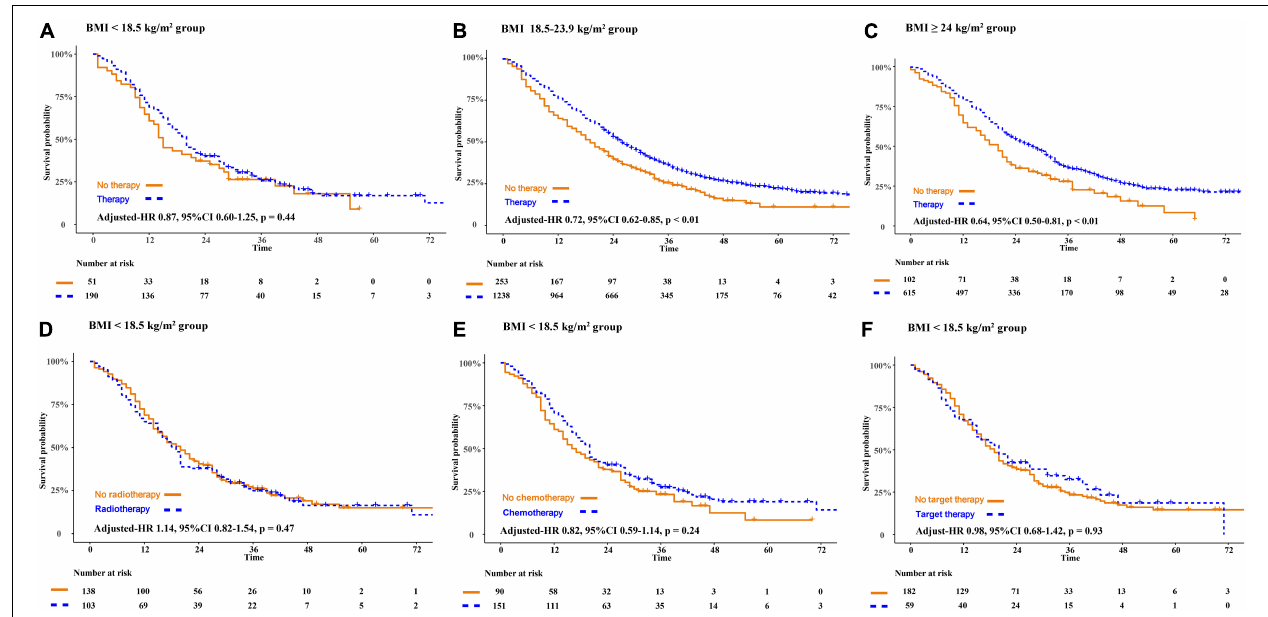
FIGURE 3 | The disparity of survival outcome in patients receiving anti-cancer therapies or not according to the classification of BMI. BMI, body mass index (recorded when brain metastases was diagnosed).